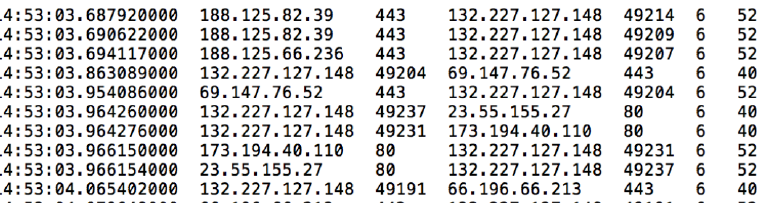
Figure 3. Example of a PCAP file output.